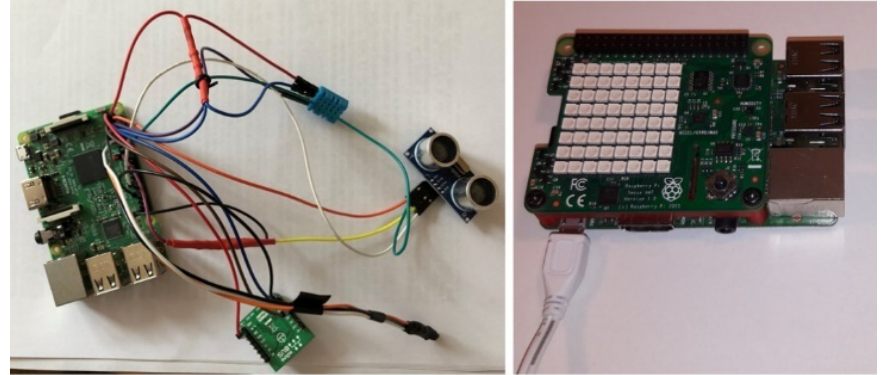
Fig. 2. Raspberry with sensors and cables (left), Raspberry Pi with sensor board